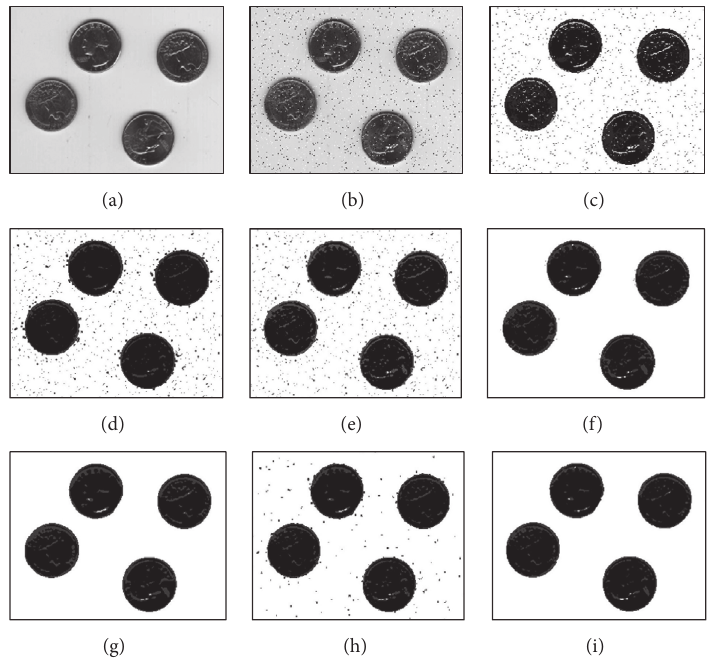
Figure 5: Segmentation result on eight image. (a) Original image. (b) Image corrupted by 30% of Salt and Pepper noise. (c) FCM result. (d) FCM S result. (e) FCM S1 result. (f) FCM S2 result. (g) RFCMLGI result. (h) RFCMLGI 1 result. (i) RFCMLGI 2